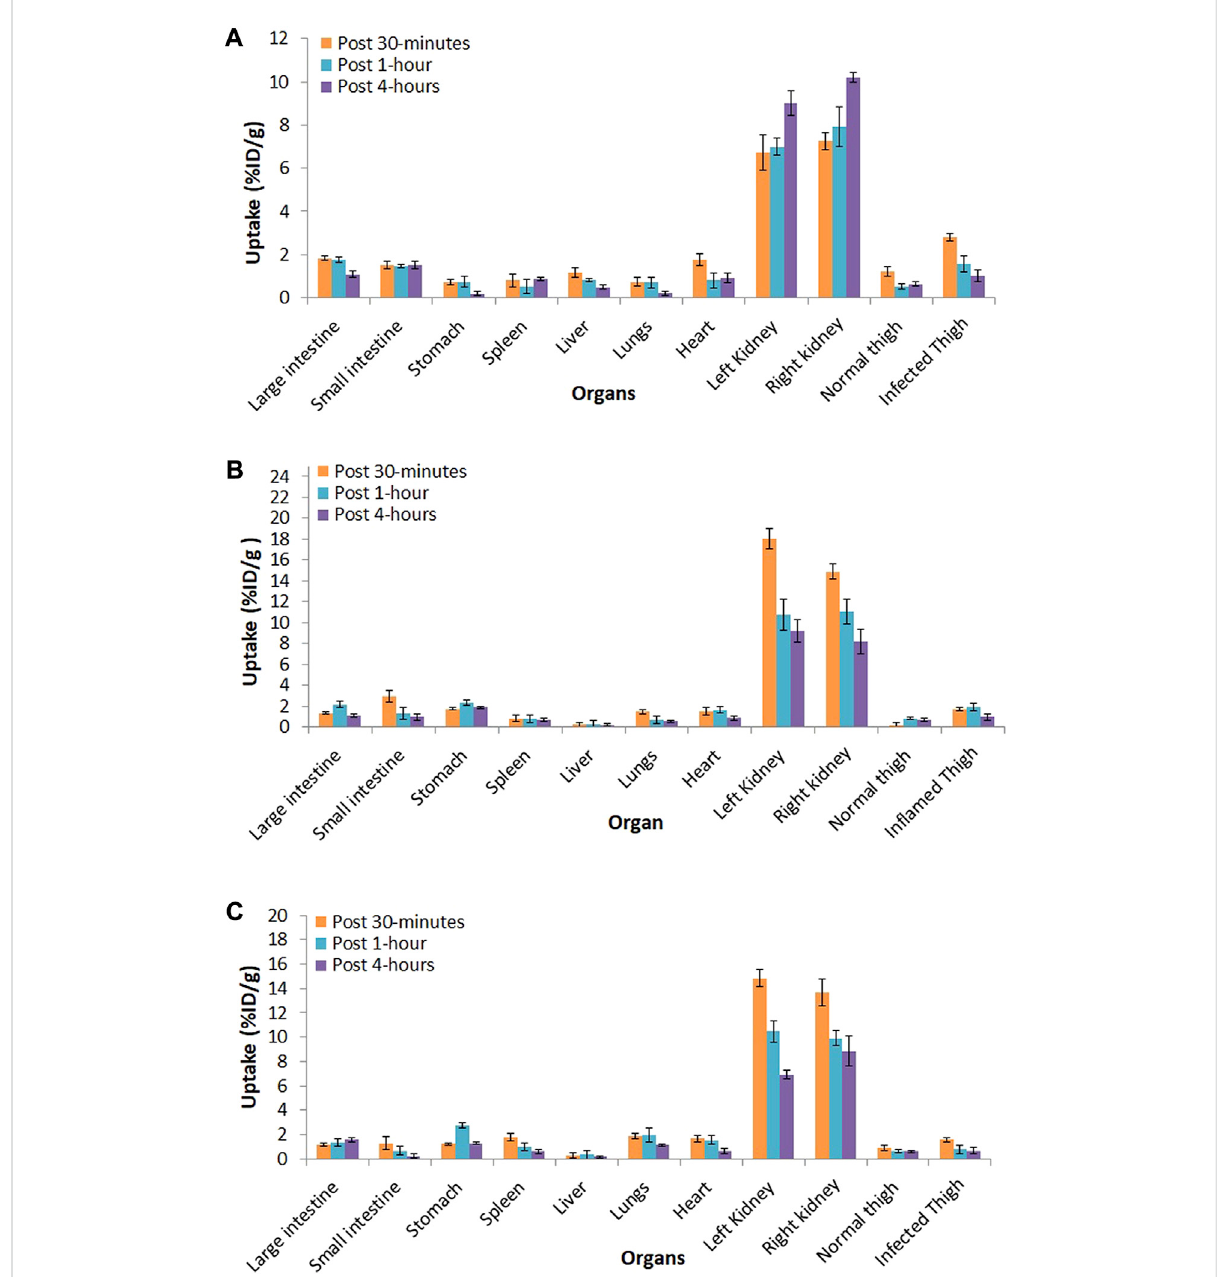
FIGURE 5 Biodistributionof 99m Tc – ertapenemin; (A) S.aureus infectioninducedratmodels, (B) E.coli infectioninducedratmodelsand, (C) in fl ammation induced rat